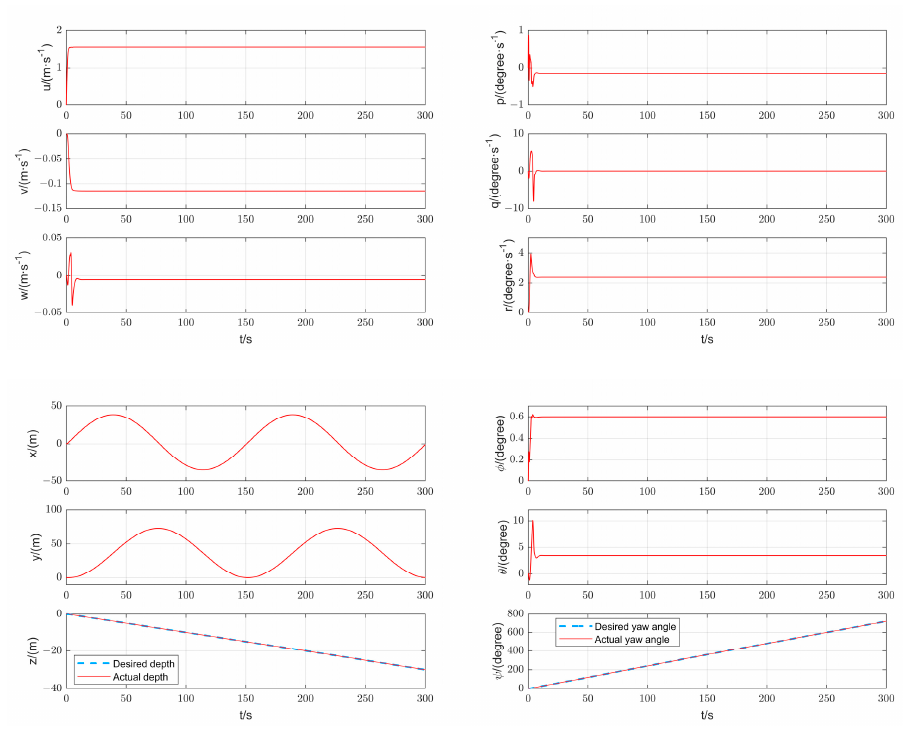
Figure 14. State response of AUV with SIFOFLC.